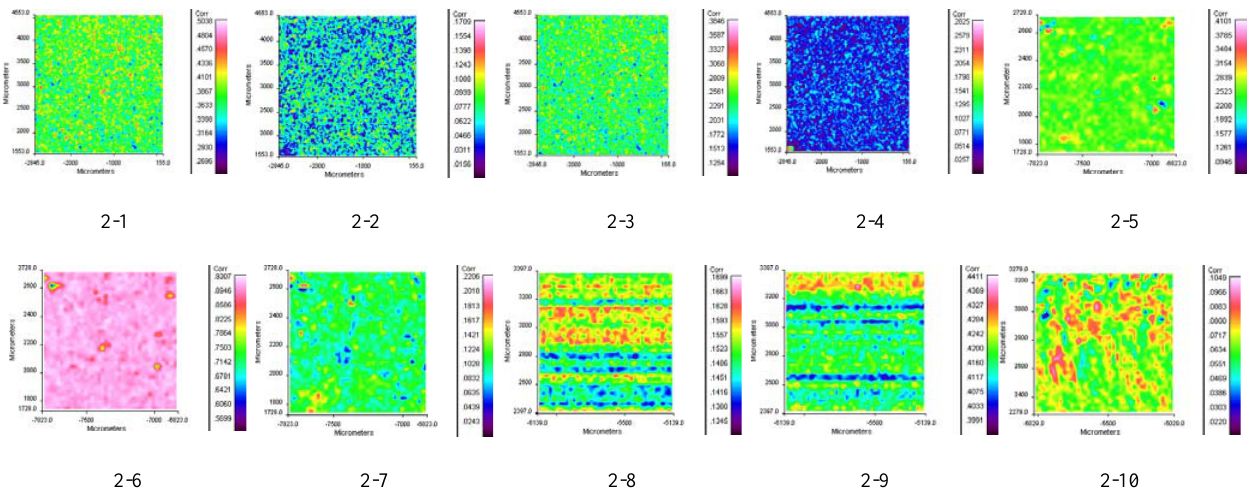
Fig. 2. Characteristic analysis of ¯ve pure spectra. 2-1, the correlation image from Radix S. Baicalensis extract with pure F. Lonicerae extract image; 2-2, the correlation image from Radix S. Baicalensis extract with pure PVPP image; 2-3, the correlation image from Radix S. Baicalensis extract with microcrystalline cellulose image; 2-4, the correlation image from Radix S. Baicalensis extract with magnesium stearate image; 2-5, the correlation image from F. Lonicerae extract with PVPP image; 2-6, the correlation image from F. Lonicerae extract with microcrystalline cellulose image; 2-7, the correlation image from F. Lonicerae extract with magnesium stearate image; 2-8, the correlation image from PVPP with microcrystalline cellulose image; 2-9, the correlation image from PVPP with magnesium stearate image; 2-10, the correlation image from microcrystalline cellulose with magnesium stearate